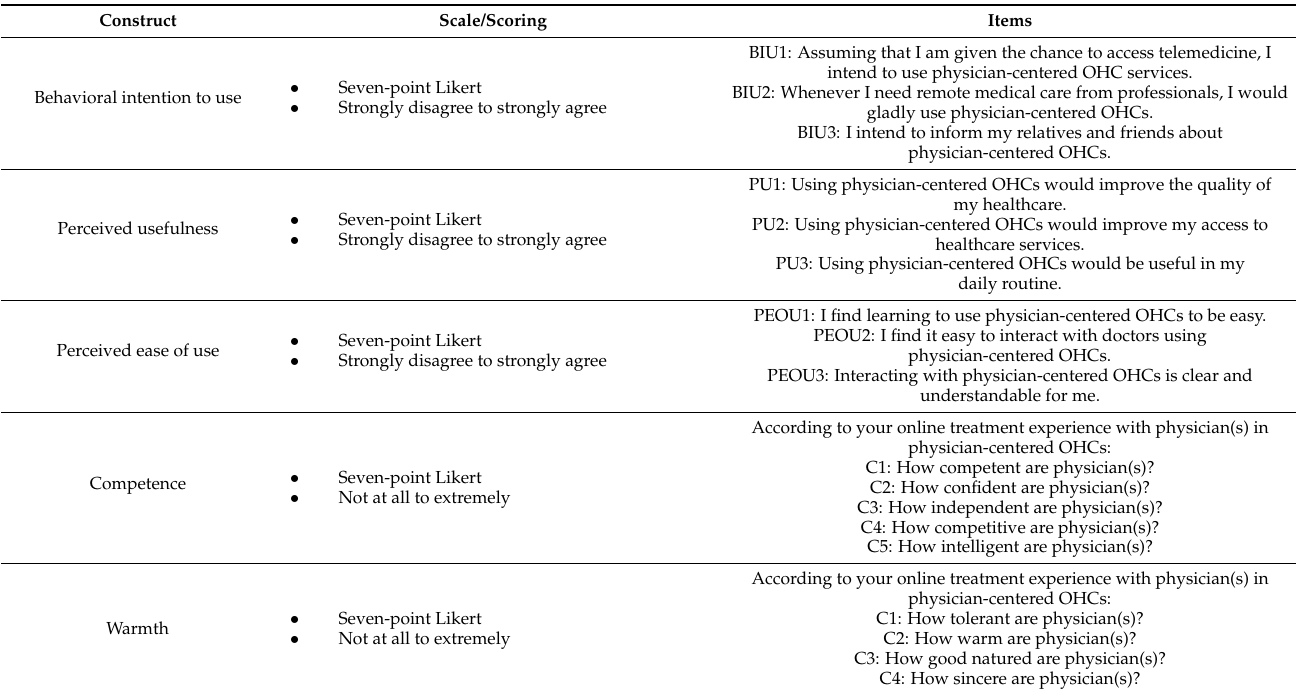
Table A1. Measurement